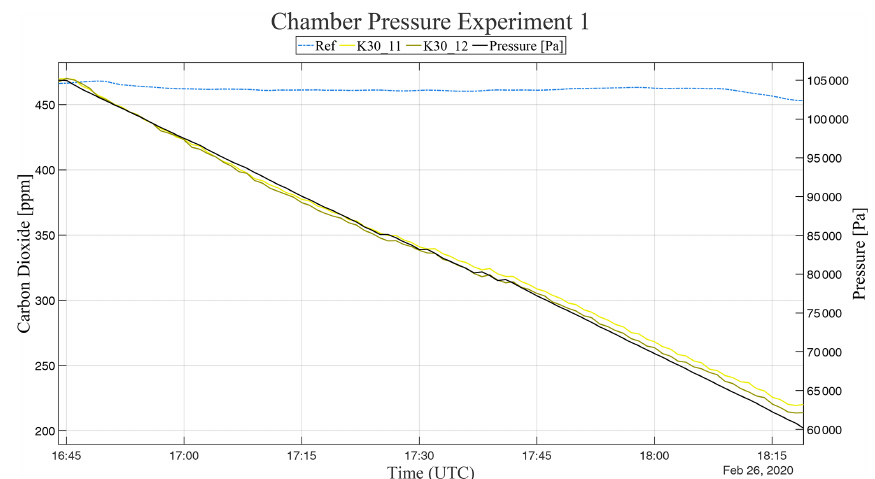
Figure 2. Time-series data for the pressure chamber experiment. The solid black curve represents the pressure inside the chamber. The yellow curves represent the CO 2 values reported by the test sensors. The dashed blue curve represents the CO 2 values reported by the reference sensor.